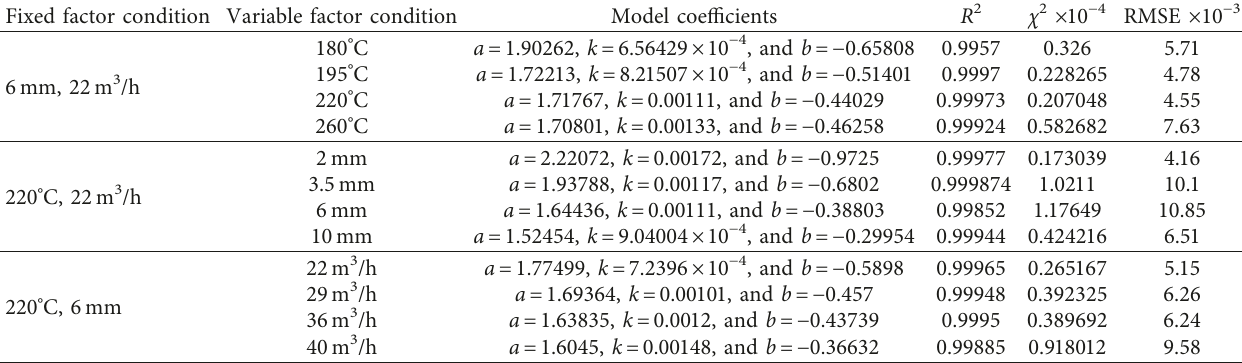
Table 8: Fitting parameter and results from the logarithmic model under different drying conditions. Fixed factor condition Variable factor condition